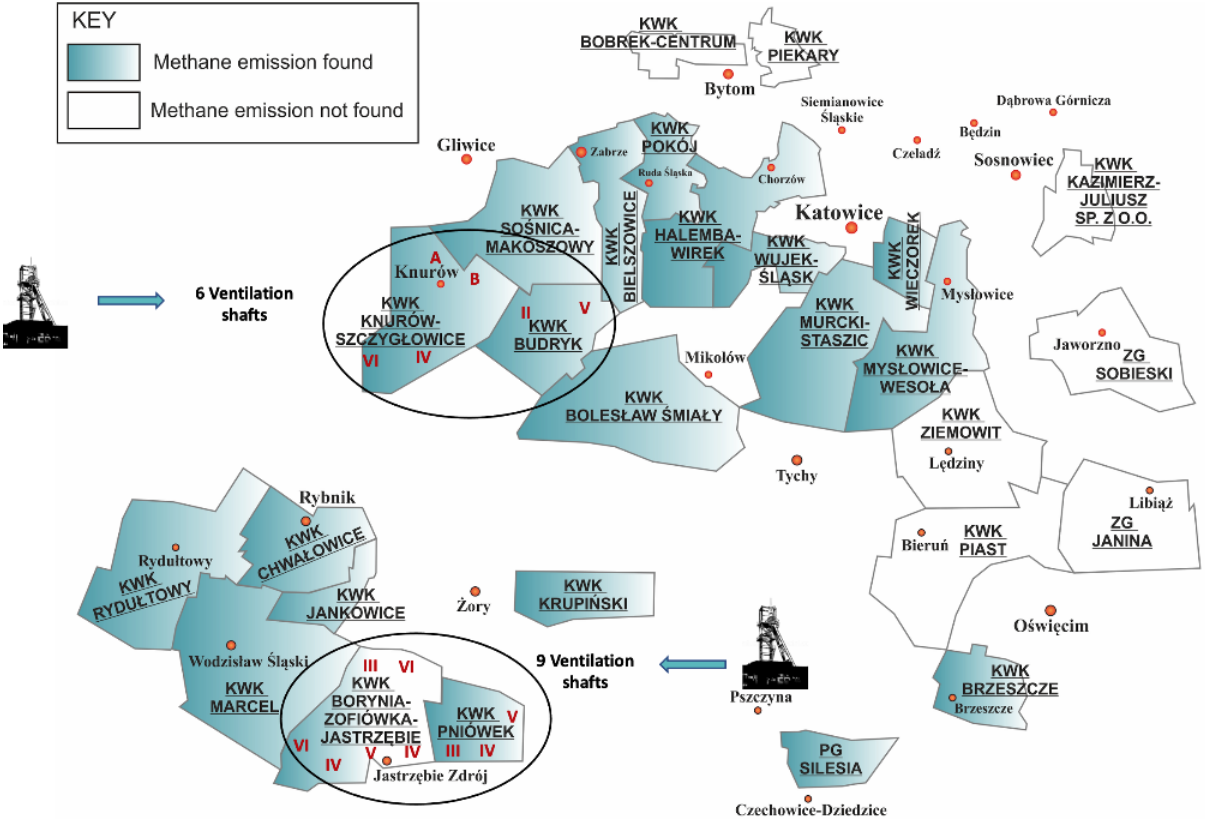
Figure 1. Map of mining areas of the Upper Silesia Coal Basin with an indication of the mines with verified methane release (demonstrative drawing). Also, the underground coal mines in the case study and their ventilation shafts are marked, as of 2018. Table 1. Methane emission from underground Polish coal mines from 2013 to 2018 (WUG,